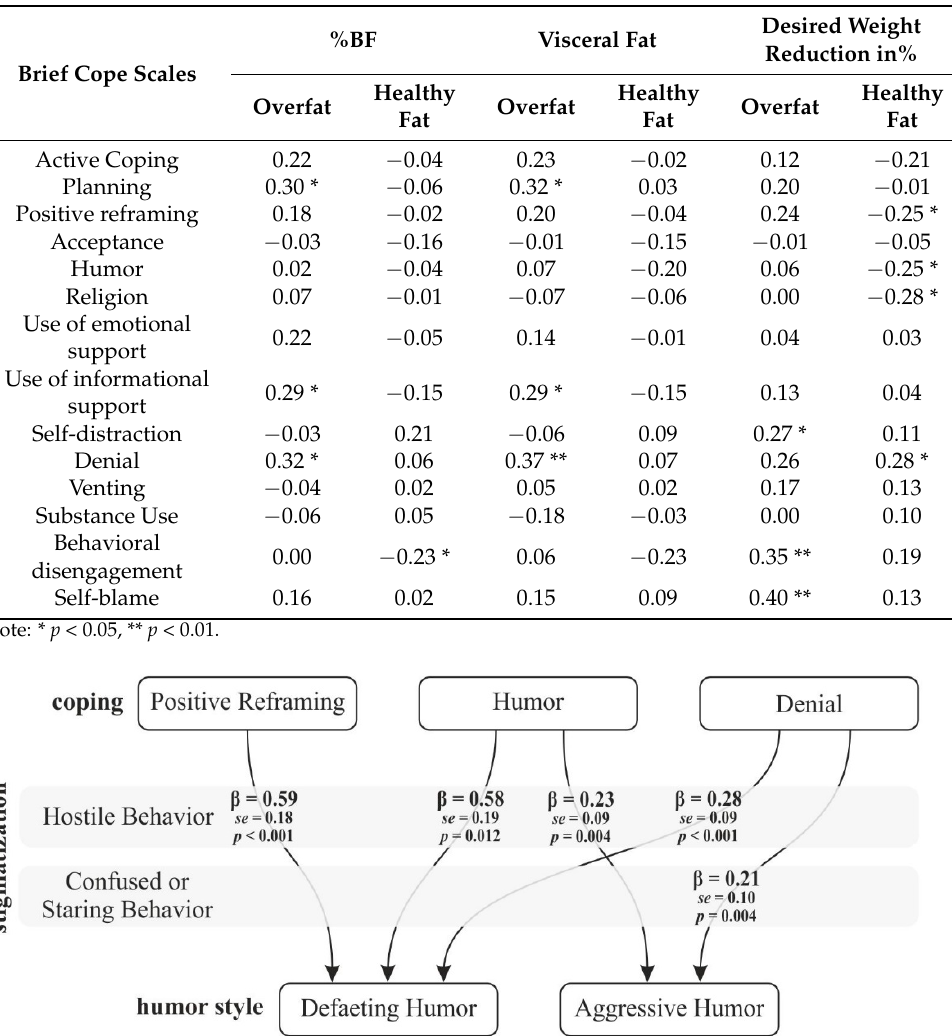
Table 3. Table of correlation between Brief COPE Scale and %BF, visceral fat, and desired weight reduction in%.